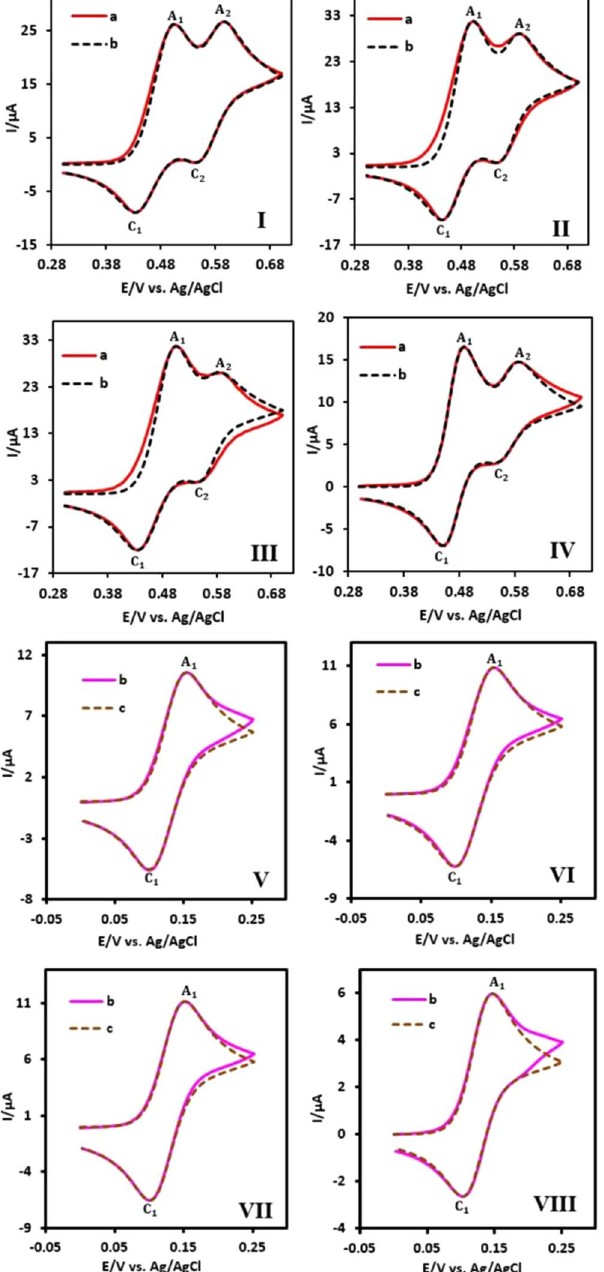
Figure 7. Experimental (a) and simulated (b) cyclic voltammograms of MAP (1 mM) in the presence of ( I and V ) p -toluenesulfinic acid (0.5 mM), ( II and VI ) benzensulfinic acid (0.5 mM), ( III and VII ) p -chlorosulfinic acid (0.5 mM) and ( IV and VIII ) methanesulfinic acid (0.5 mM) at glassy carbon electrode. In I – IV ; solvent, aqueous HClO 4 (0.1 M) and scan rate: 80 mV/s. In V – VIII , solvent, aqueous phosphate buffer (pH = 6.0, c = 0.2 M) and scan rate: 10 mV/s. Temperature = 25 ± 1